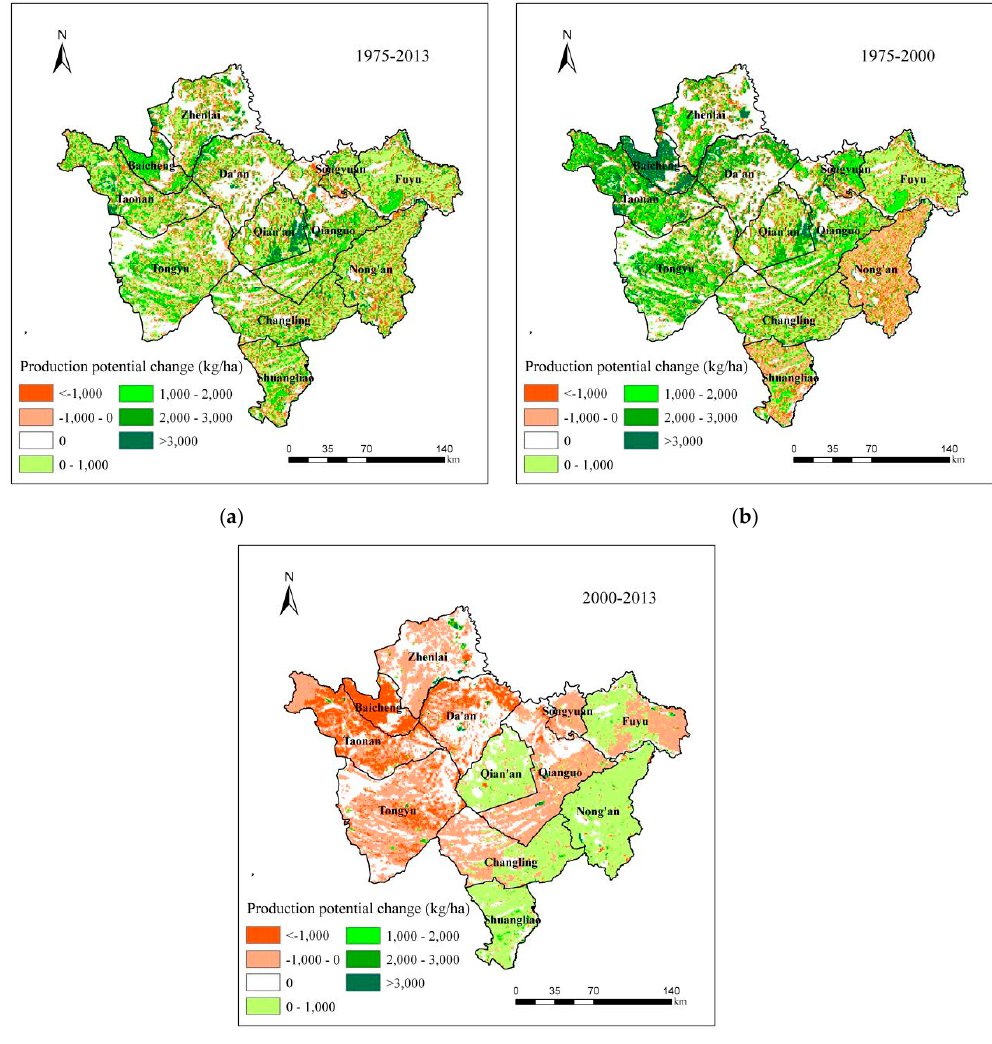
Figure 7. Soybean production potential change between 1975 and 2000, between 2000 and 2013, and between 1975 and 2013. ( a ) between 1975 and 2000; ( b ) between 2000 and 2013; ( c ) between 1975 and 2013.